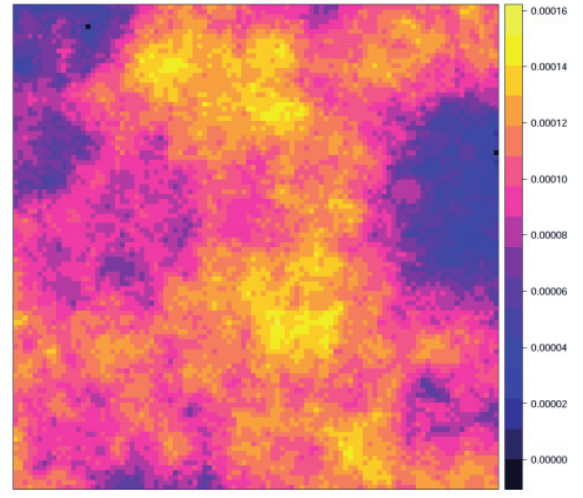
Figure 4. Resulting focus map obtained by the multiplicative pool- ing of the simulated spatial distributions of hazard and exposure de- picted in Figures 1 and 2. A simple min-max mapping, and an equal weighting scheme have been used.